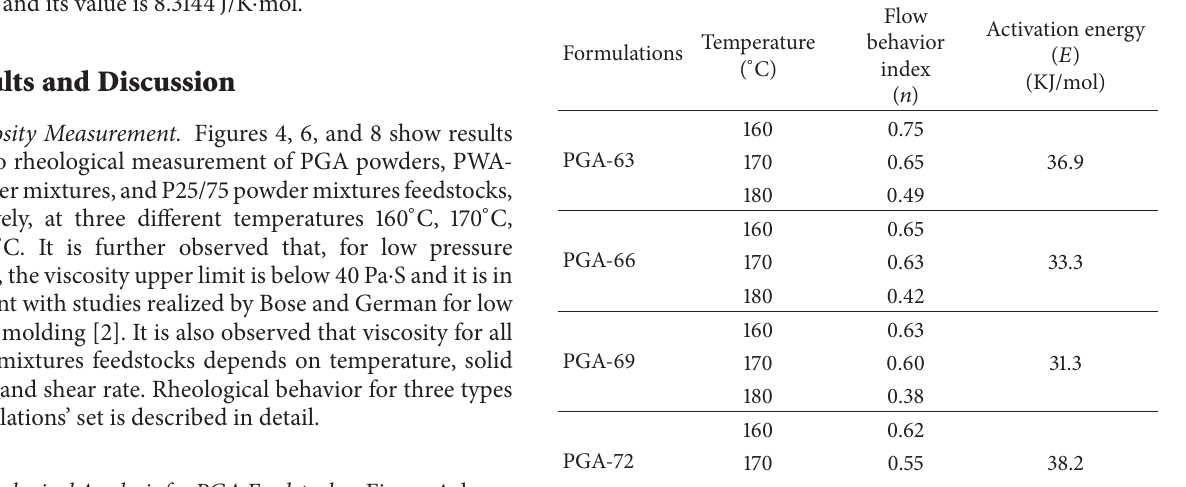
Table 2: Values of 𝑛 and 𝐸 for PGA